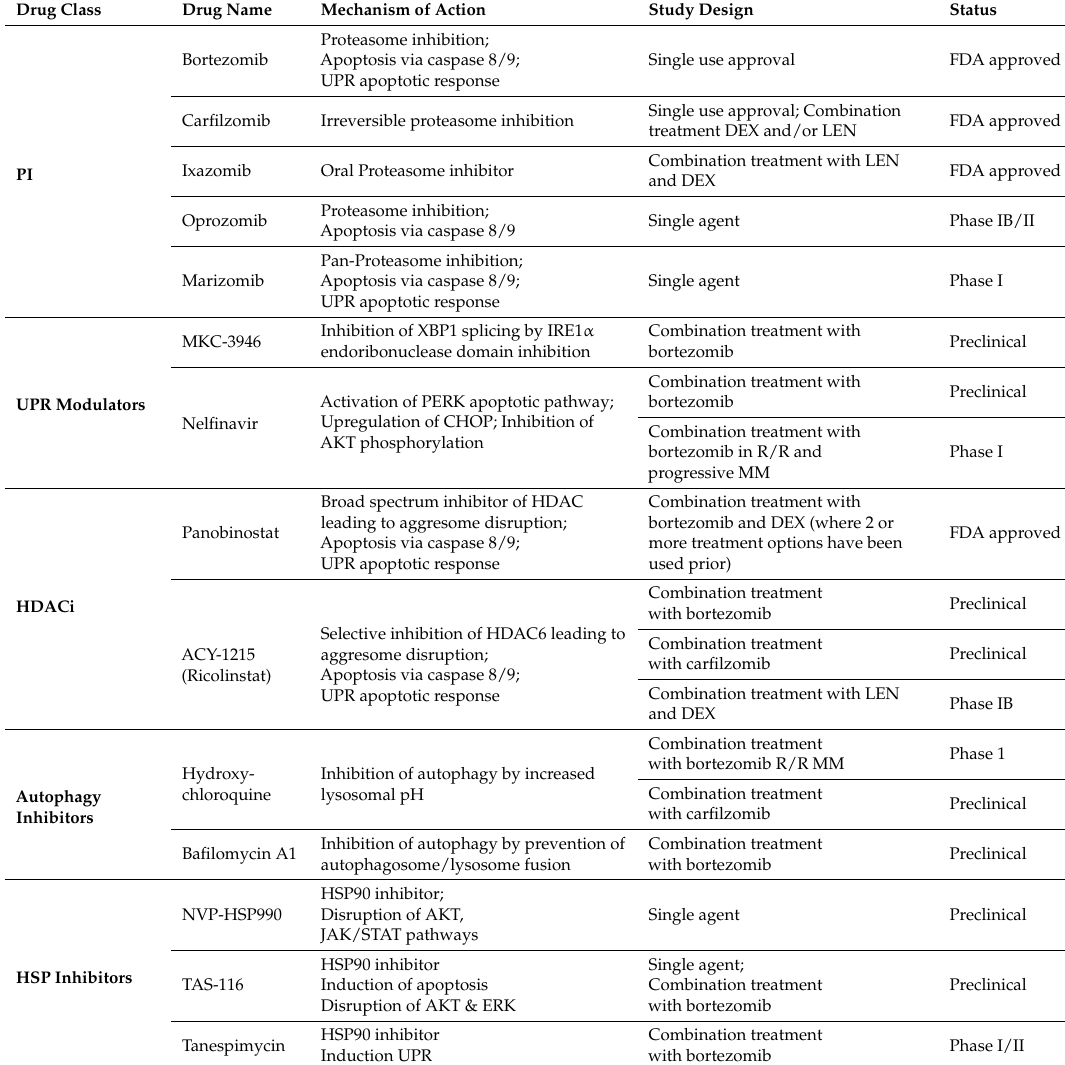
Table 1. Therapies targeting protein handling pathways in multiple myeloma